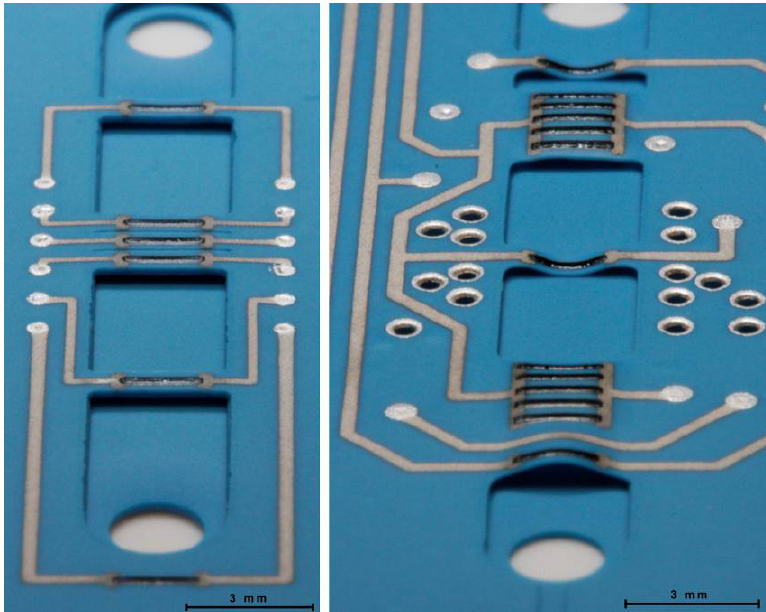
Figure 10. Close-ups on voluntarily incomplete LTCC sensors. (Left) Flow sensor prototype [22]: the bridges are intact because Ag:Pd tracks leading to resistors are narrow (0.15 mm), and thus induced deformations are negligible. (Right) Integrated sensor: strong deformations of suspended bridges. Note the difference of buckling between resistor blocks, single resistor bridges, and full conductor bridge due to the thick Ag:Pd conductor tracks (0.3 mm).